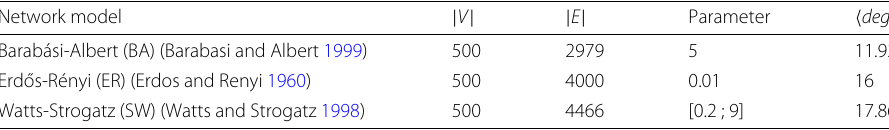
Table 2 Synthetic network